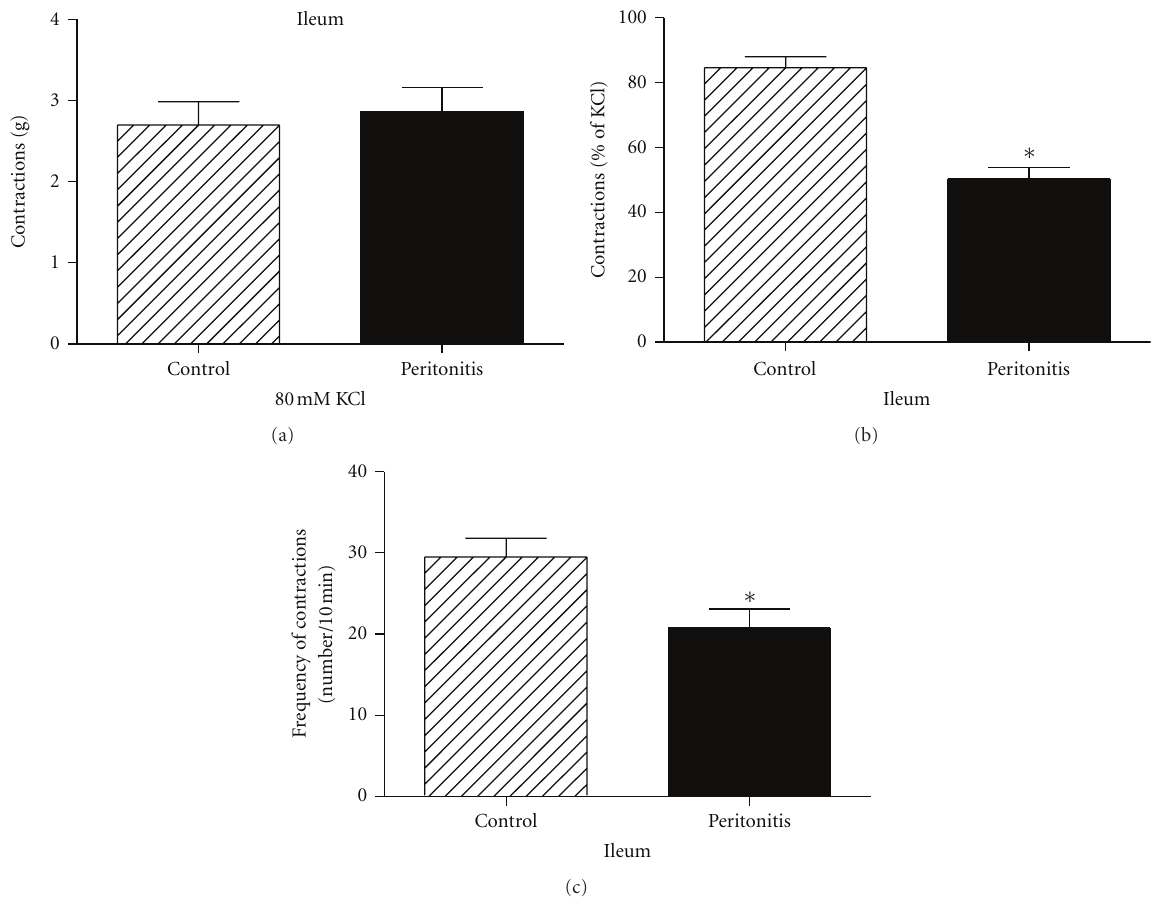
Figure 1: (a) KCl (80mmol/L) induced contractions of isolated ileum muscle segments in control and peritonitis groups. (b) Changes in the amplitude of spontaneous contractions of the isolated ileum muscle segments. Amplitudes were calculated as a percentage of the contraction induced by KCl (80mmol/L) from both control and peritonitis groups. (c) Changes in the frequency of spontaneous contractions of the isolated ileum muscle segments. Frequencies were expressed as the number of contractions for 10 min from both control and peritonitis groups. ( ∗ P < 0 . 05 versus control group; analysis of variance followed by Tukey